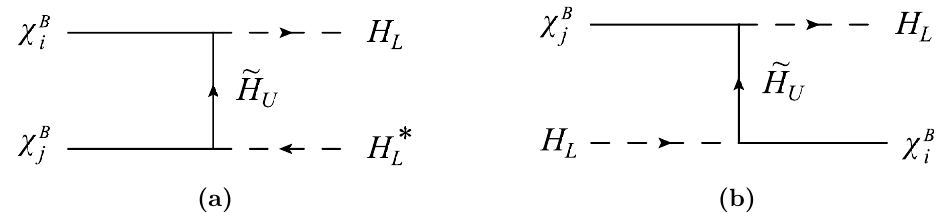
Figure 19. (a) Example of diagram contributing to bino annihilation to Higgses. (b) Example of diagram contributing to bino conversion via Higgs